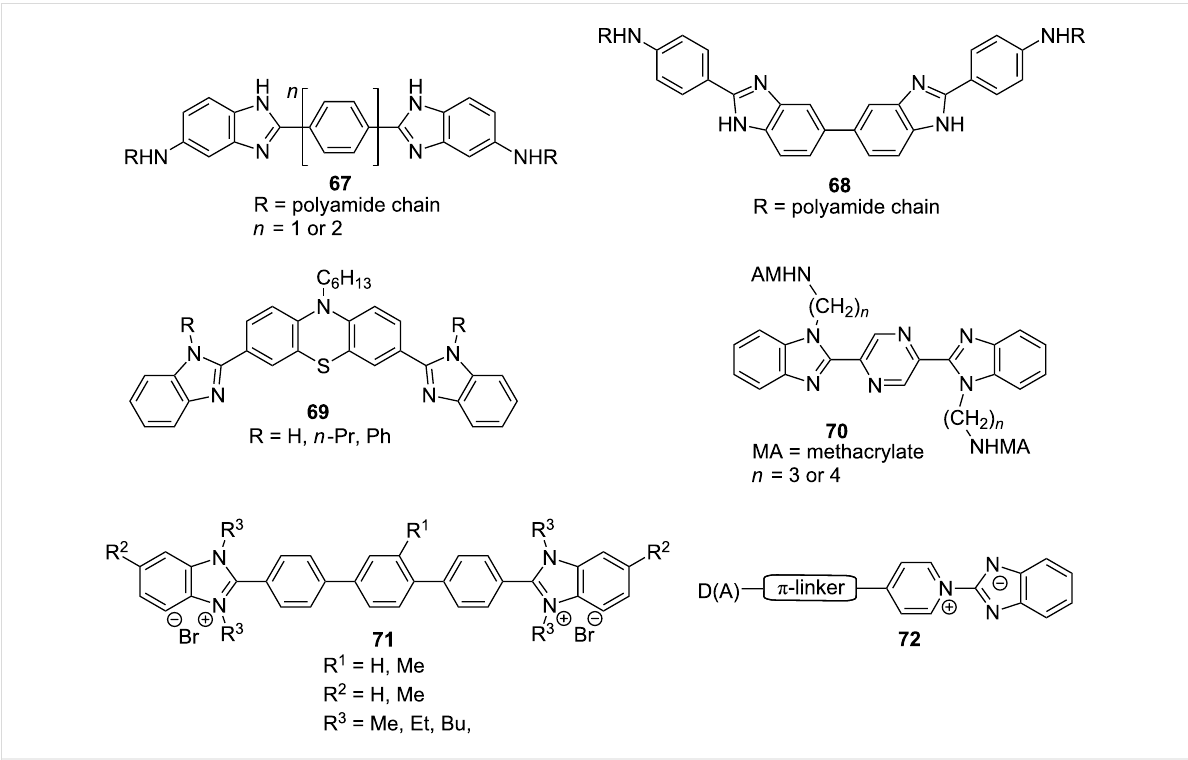
Figure 13: General structures of bis(benzimidazole) chromophores 67 – 71 and pyridinium betaines 72 [75-79].